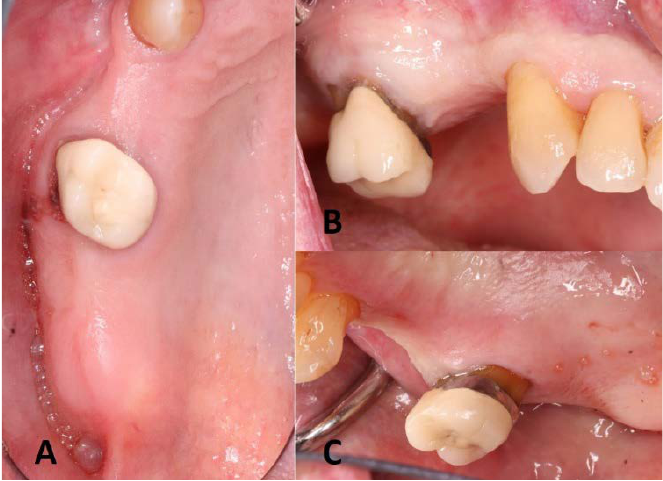
Figure 1. Preoperative clinical assessment: ( A ) occlusal; ( B ) buccal; ( C ) palatal view of the maxillary right sextant.